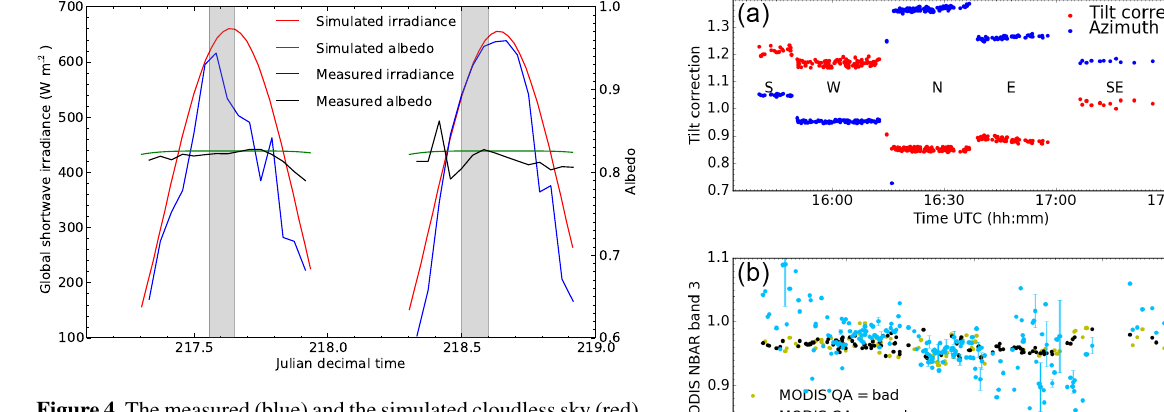
Figure 4. The measured (blue) and the simulated cloudless sky (red) downwelling shortwave radiation for Summit, Greenland, on 5 Au- gust (day 217) and 6 August (day 218) 2010. The measured (black) and simulated (green) shortwave broadband albedos are also shown. The grey shaded areas indicate the time when the UAS was flying.